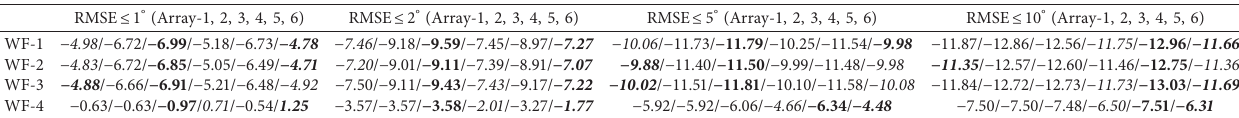
Table 5: SNR (dB) values when arrays can produce 50% correct results using 1025 snapshots under different estimation accuracies. RMSE ≤ 1 ° (Array-1, 2, 3, 4, 5, 6) RMSE ≤ 2 ° (Array-1, 2, 3, 4, 5, 6) RMSE ≤ 5 ° (Array-1, 2, 3, 4, 5, 6) RMSE ≤ 10 ° (Array-1, 2, 3, 4, 5,